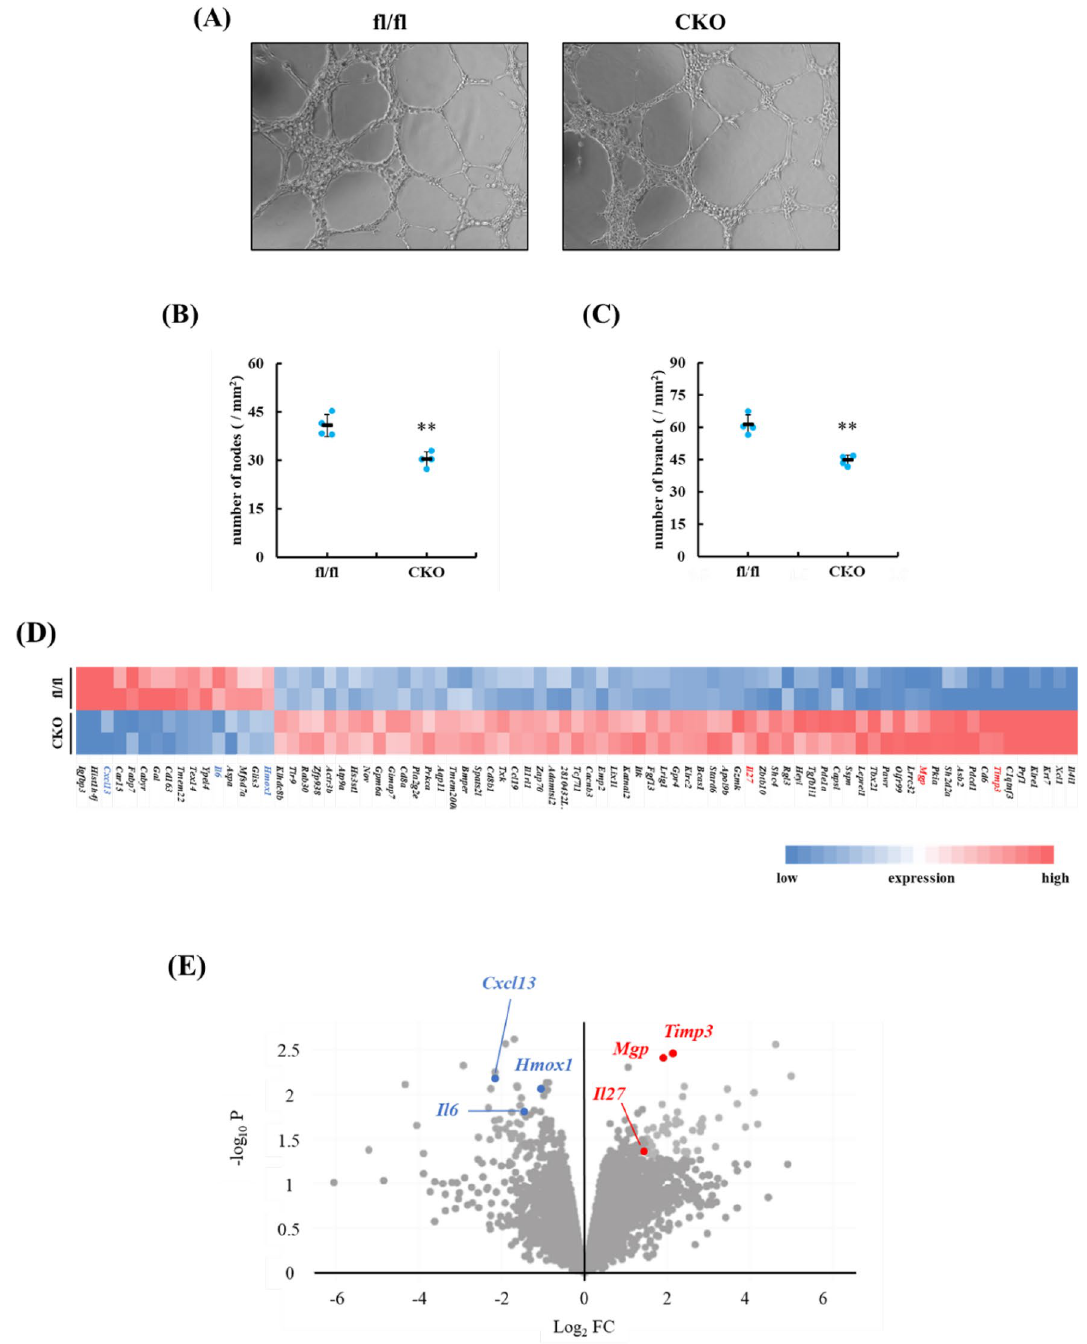
Figure 5. Runx2 ablation impaired angiogenic activity of infiltrated myeloid cells following MI. ( A – C ) CD11b + cells were prepared from Runx2 fl/fl and Runx2 CKO hearts 7 days after MI and cultured for 24 h. Conditioned media from CD11b + myeloid cells of Runx2 fl/fl and Runx2 CKO were added to HUVECs. After 8 h, tube formation of HUVECs was evaluated. ( A ) Representative images of tube formation are shown. The number of nodes ( B ) and branches ( C ) was measured. Data are shown as mean ± SD (n = 4 for each condition) * P < 0.05 vs Runx2 fl/fl by student’s t -test. ( D , E ) CD11b + F4/80 + macrophages were isolated from hearts of Runx2 fl/fl and Runx2 CKO mice at 7 days after MI. Total mRNA was extracted from the cells and RNA-sequence was performed (n = 2 in each group). Pro-angiogenic factors were indicated by blue letters, while anti-angiogenic factors by red ( D ) Heat map shows the gene with > 2.0-fold change between Runx2 fl//fl and Runx2 CKO with a P -value of < 0.05. ( E ) Volcano plots represent angiogenic gene expression compared Runx2 fl/fl vs Runx2